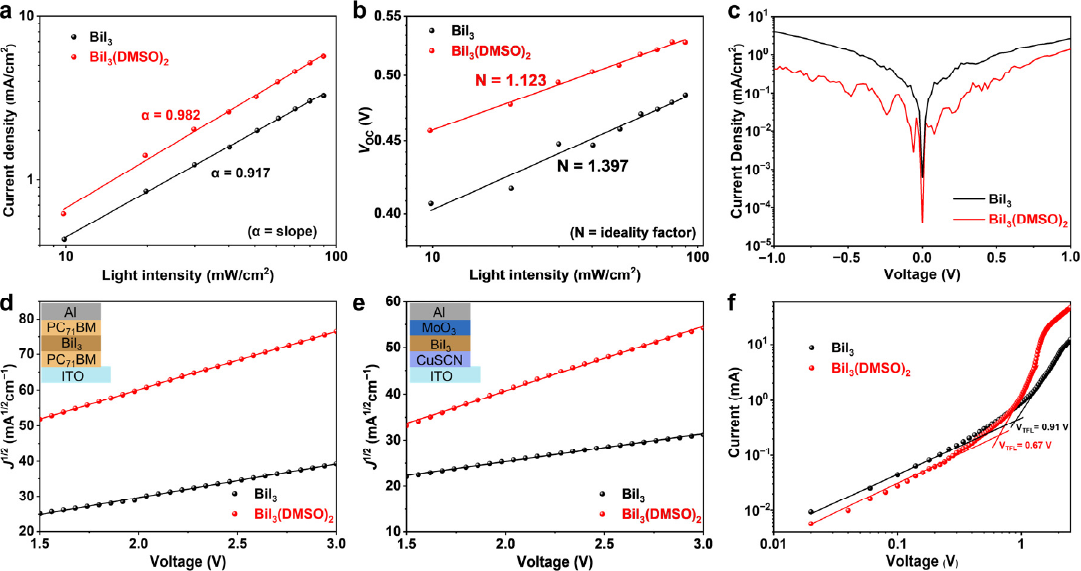
Figure 5. Light intensity-dependent ( a ) J SC , ( b ) V OC , and ( c ) dark J − V curves of devices with BiI 3 and DMSO-coordinated BiI 3 film. ( d ) Electron mobility, ( e ) hole mobility, and ( f ) trap density calculated from J–V curves of single-carrier devices with BiI 3 and DMSO-coordinated BiI 3 film.